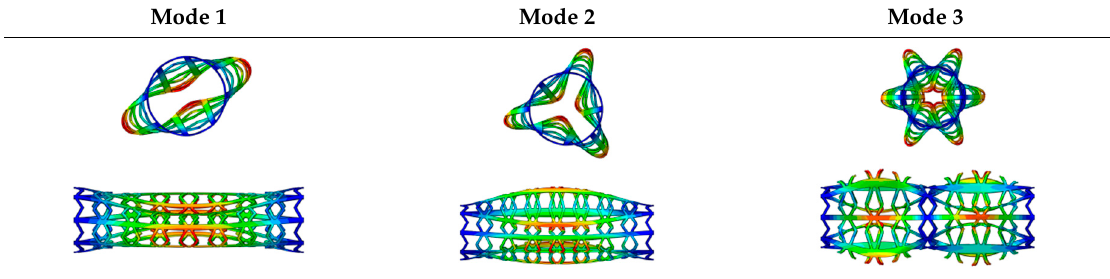
Table 3. The first three buckling modes of SMP stent with Nc = 8 Mode 1 Mode 2 Mode 3